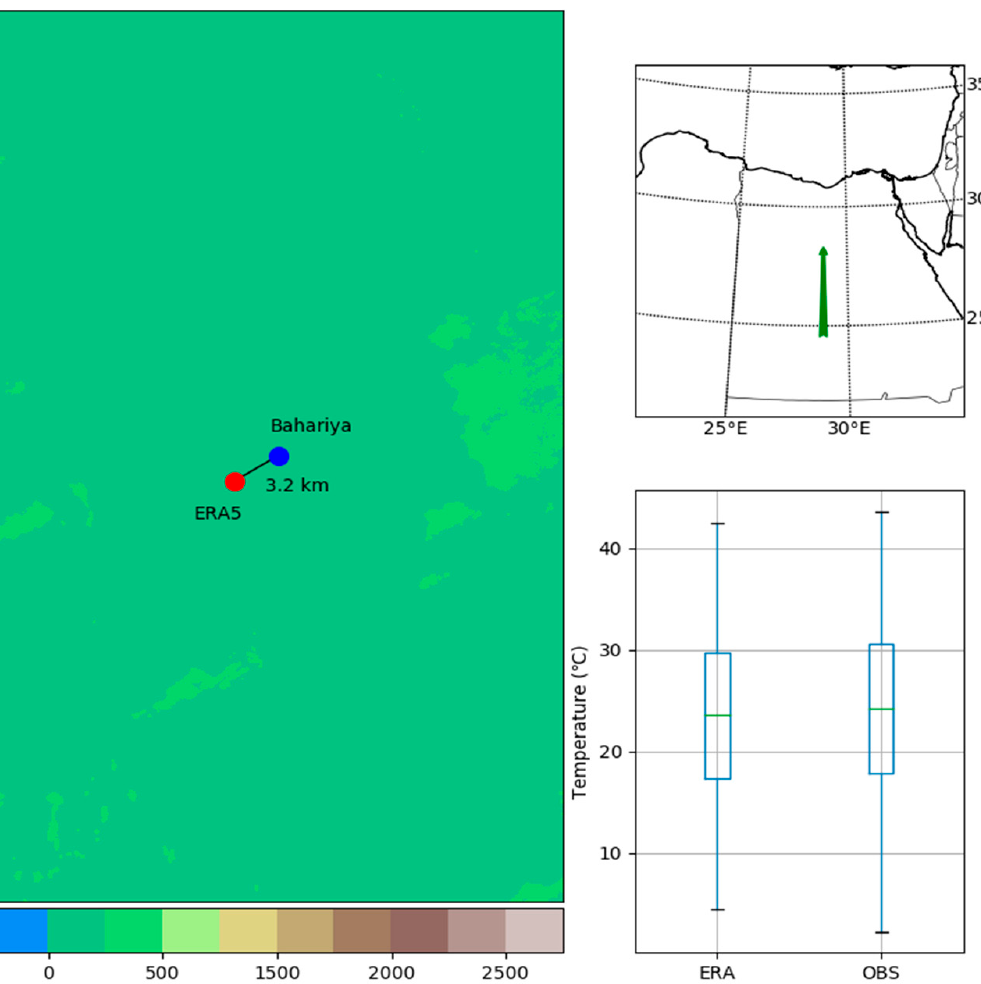
Figure 3. Altitude (m a.s.l.) and position of the el-Bahariya oasis (Egypt) automated weather station (AWS).